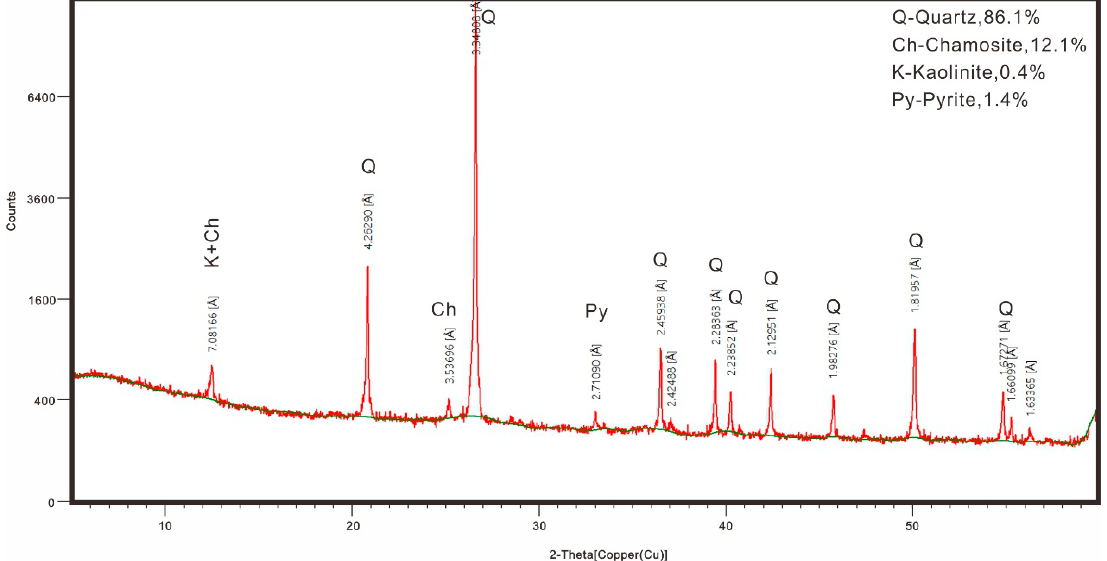
Figure 3. X-ray power diffraction patterns of C1 coal.